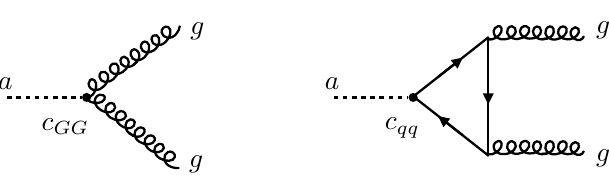
Figure 1 . Contributions to the a → gg decay amplitude involving the ALP-gluon coupling (left) and the ALP couplings to quarks (right). The ALP is drawn as a dotted line. The black circles indicate vertices deriving from the dimension-5 operators in the effective Lagrangian (2.1). Here the traces are over generation indices. T group generators, N isospin components. Y